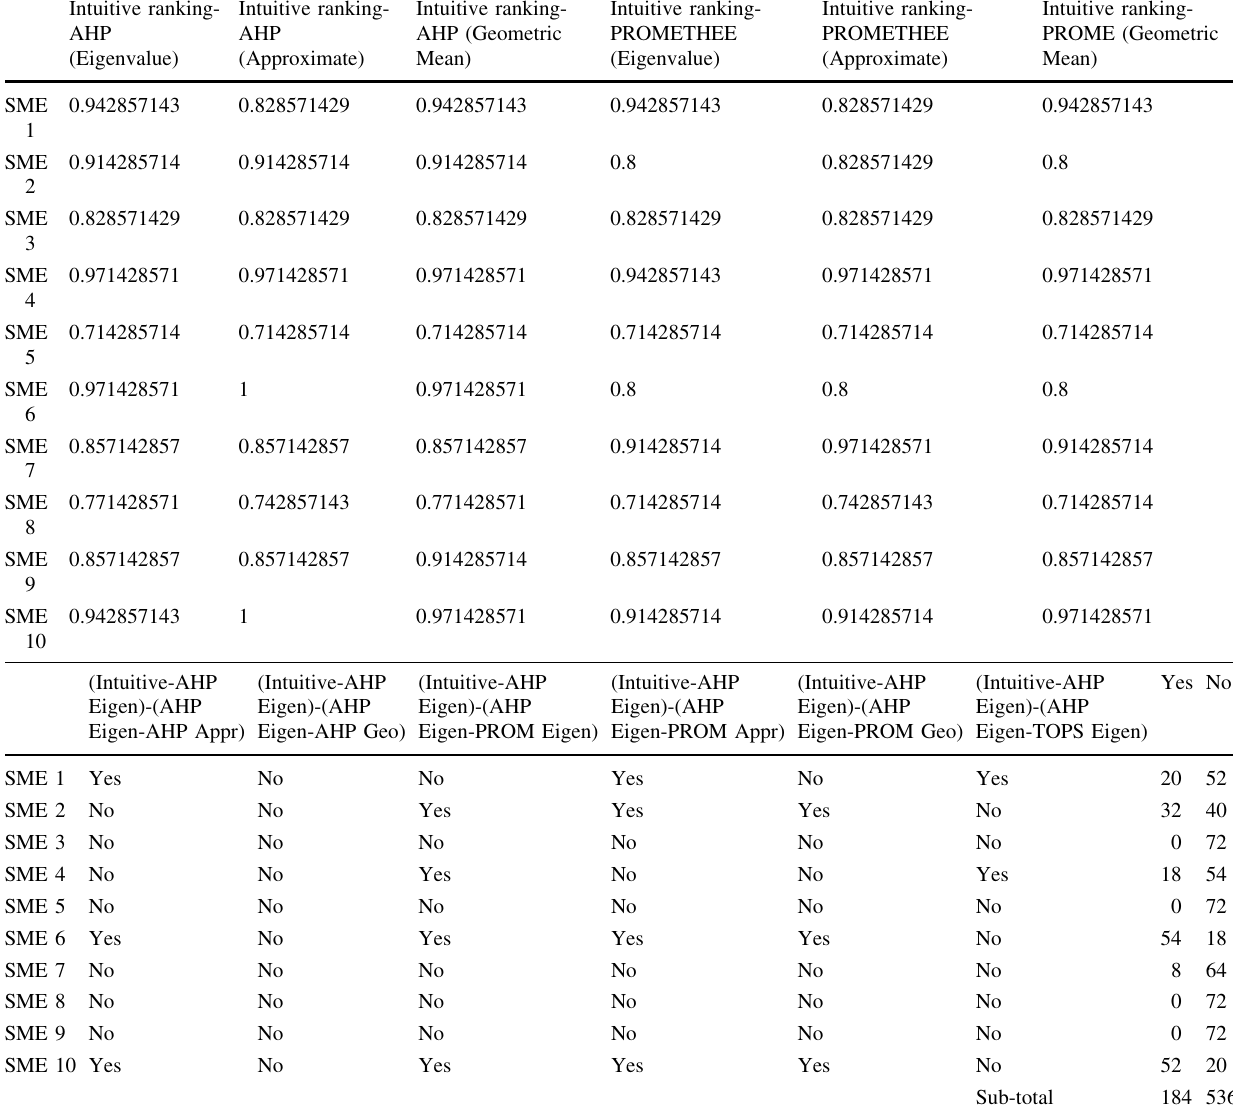
Table 23 Summary Kendall’s coefficients of concordance